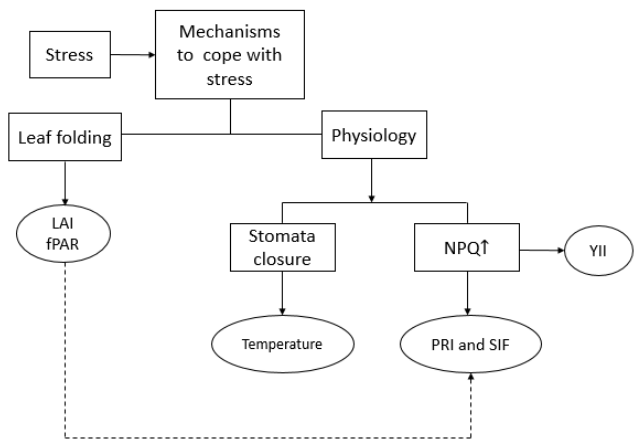
Figure 11. The framework of how plants cope with water stress. The dotted line indicates an indirect effect. Ellipses indicate measurable data.